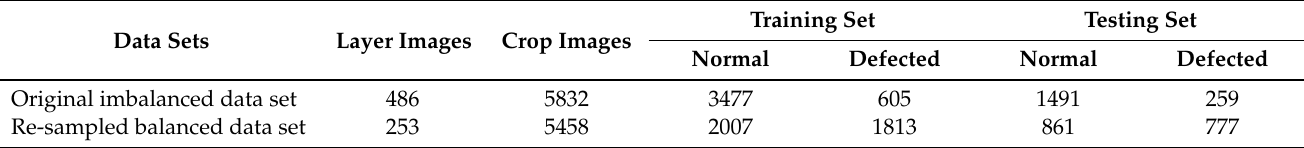
Table 5. Training and testing data